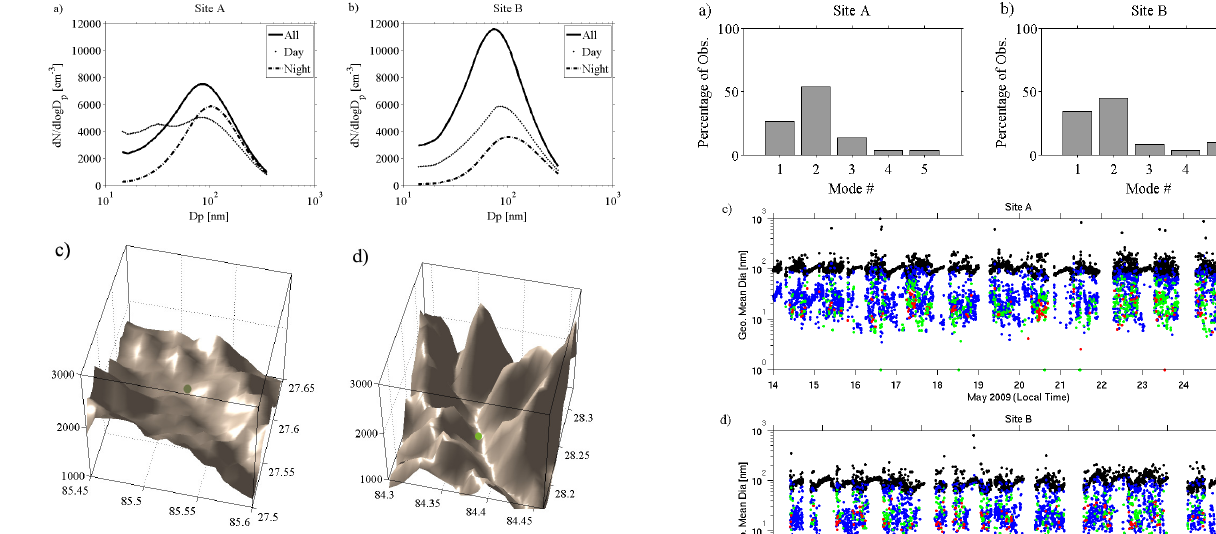
Figure 5: Mean aerosol size distribution for the entire sampling period a) Site A and b) Site B. All represents the whole samples. Day represents the sampling done from 1000~1700hrs LT and Night represents sampling period from 2300~0400 hrs LT. The windows used for day and night period filters out the sampling of locally emissions., c-d) Topographic relief of sampling stations at Site A and Site B respectively, showing the narrow N-S oriented river valley for Site B compared to the open terrain of Site A, surrounded by series of small hills.